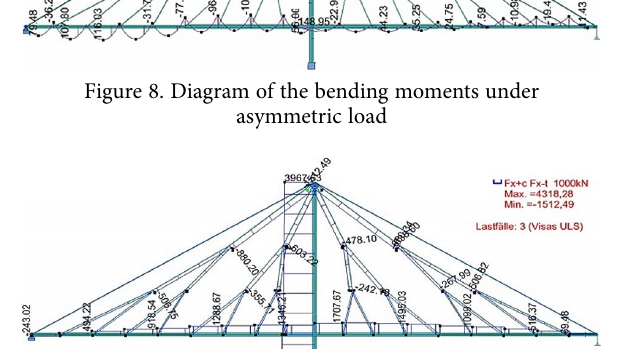
Figure 5. The new innovative branched cable-stayed bridge structure scheme